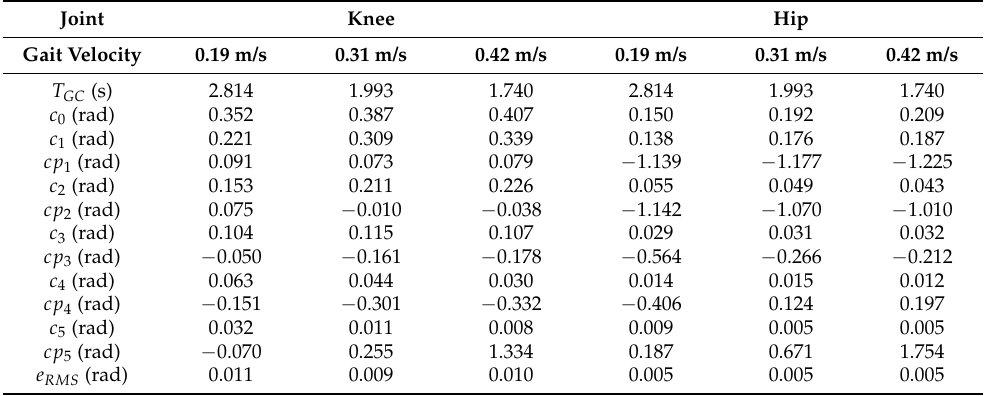
Figure 10. Reference angle and torque profiles for hip and knee joint in gait on the treadmill. These are averaged data. The shaded areas represent the standard deviation. Table 3. Coefficients and RMSE for a Fourier representation of the gait of the knee and hip joint trajectories at different gait velocities. The RMSE is indicated for the Fourier sequence